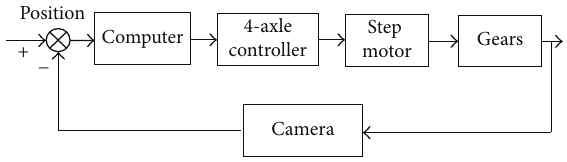
Figure 3: Sketch map of the control